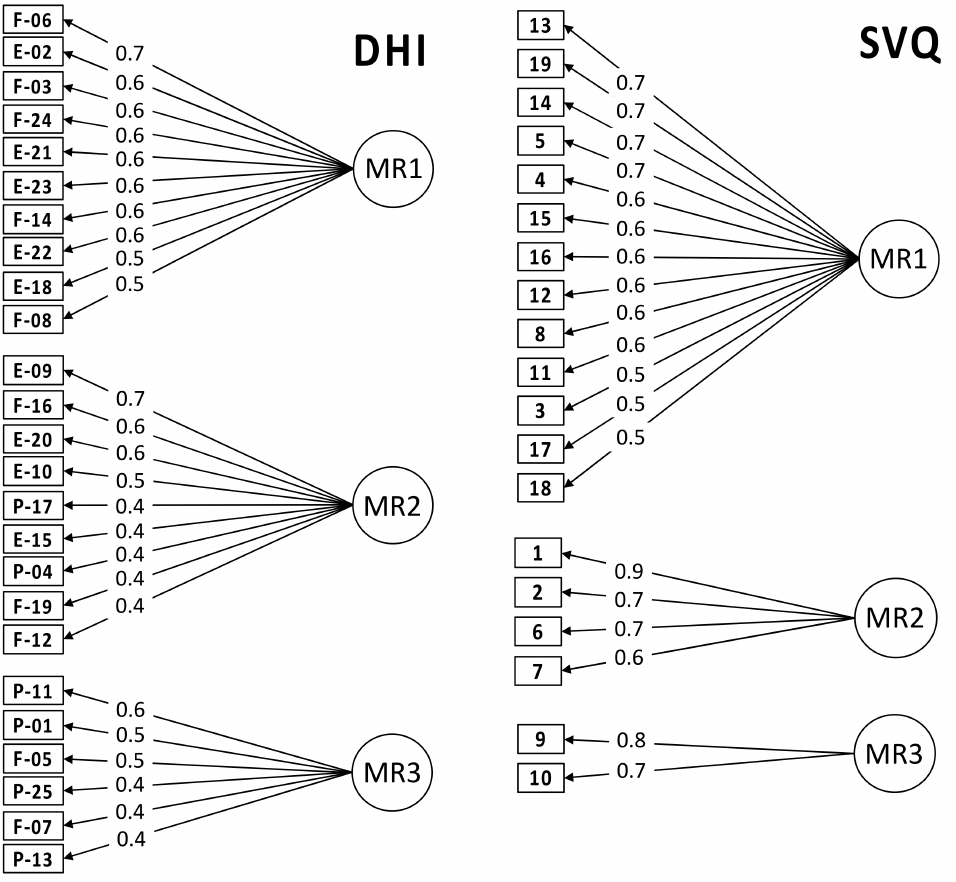
Figure 6. Factor structures derived from the Exploratory Factor Analysis of the Dizziness Handicap Inventory (DHI) ( left ) and Situational Vertigo Questionnaire (SVQ) ( right ) items. A significant three- factor structure (MR1, MR2, and MR3, MR = minimum residual) was derived for the DHI items. The arrows represent the best item-factor association, and the numbers represent the loadings. In the analysis of DHI data, the letters E, F, and P indicate the Emotional, Functional, and Physical components of the test,